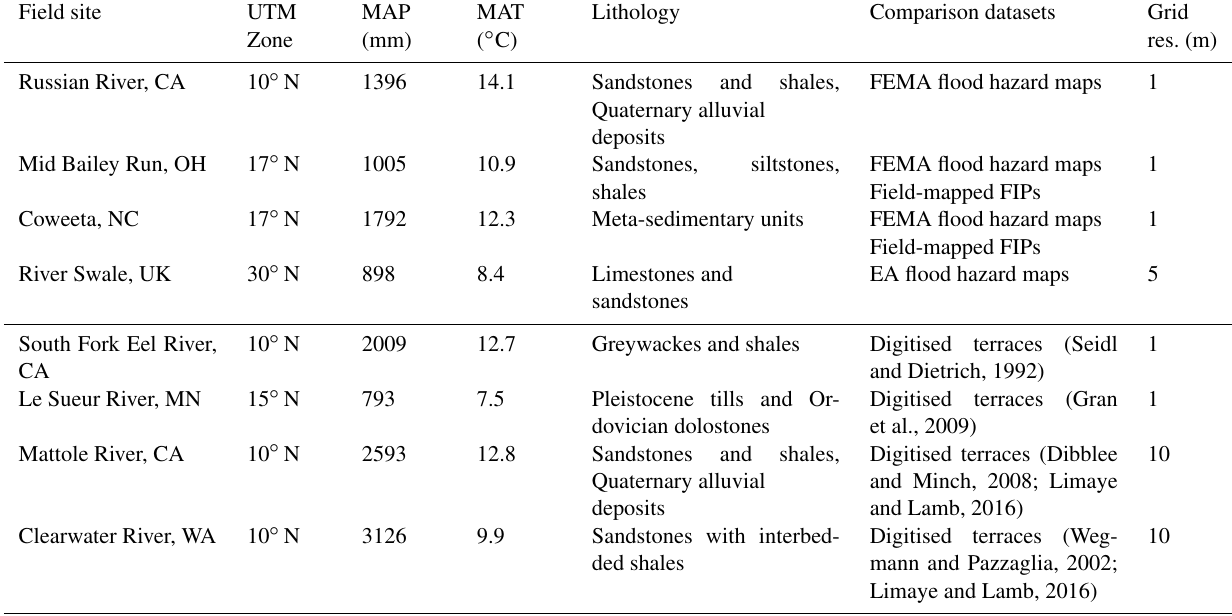
Table 2. Details of climate and lithology for each field site. Field site Comparison datasets Grid